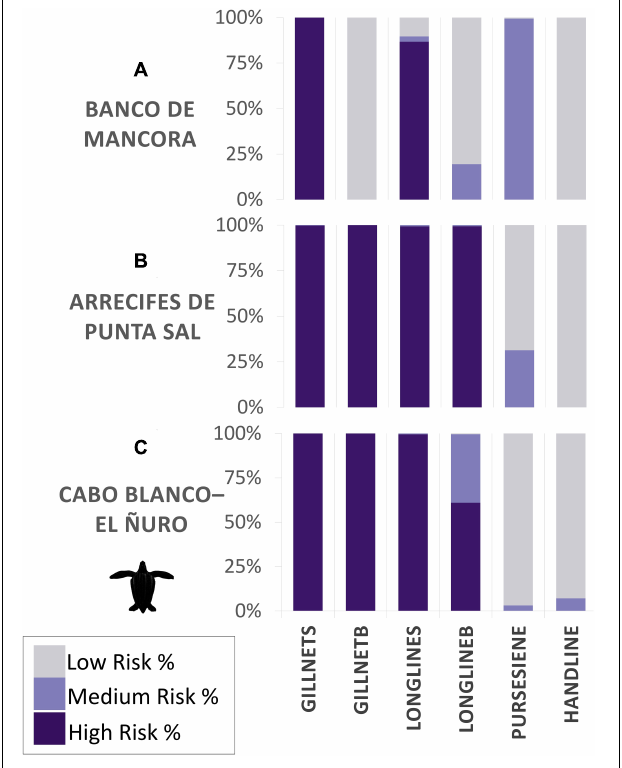
bias and consequent misidentification of habitat (van Strien et al., 2013; Pennino et al.,